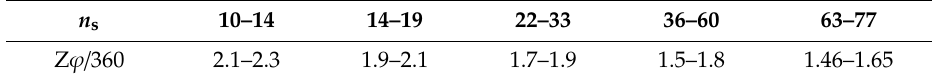
Table 6. Selection of wrap angle.